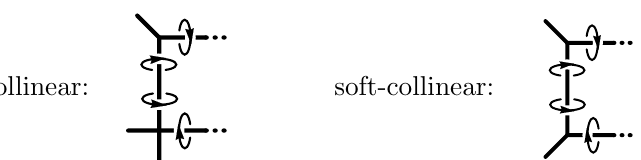
Figure 3 . Spurious IR singularities from individual boxes. The double circle indicates a composite residue of the three propagators as well as the